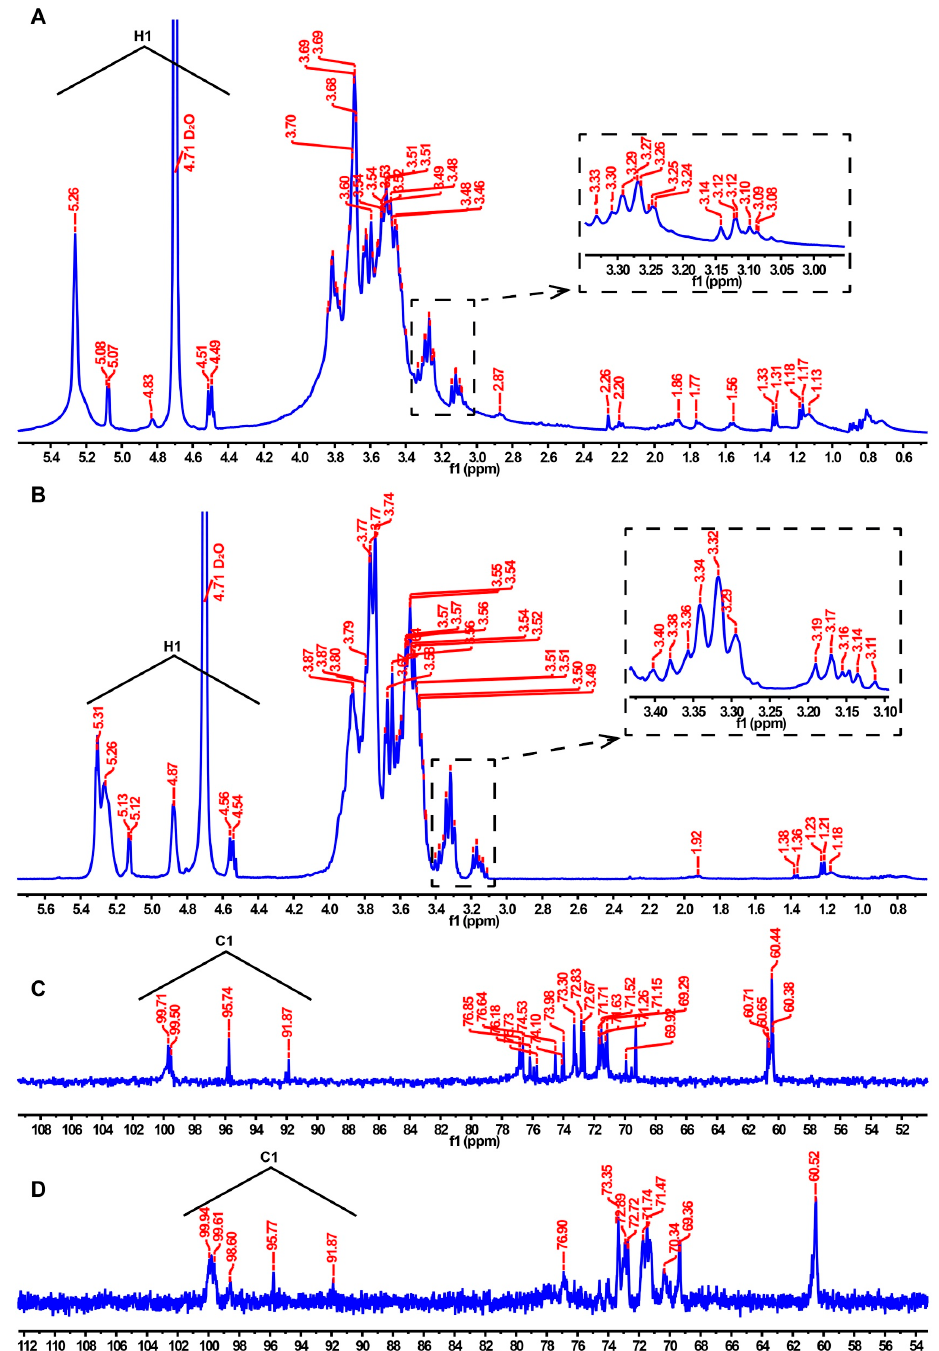
Figure 4. 1 H NMR and 13 C NMR spectra of MPS ( A , C ) and Se-MPS ( B , D ).